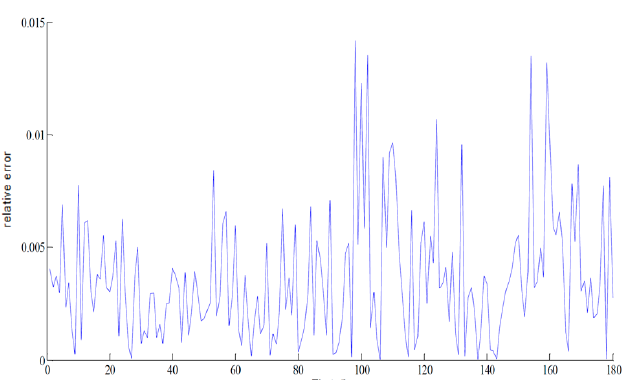
Figure 8. The relative error of the current of ship model by MLFMA and CS-MLFMA based on DCT basis.